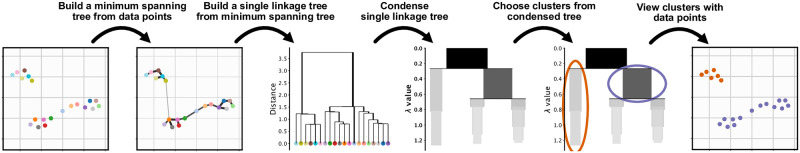
HDBSCAN density-based clustering.Clusters are found by generating a graphical representation of data, and then clustering on the graph. The data shown in this figure are from the latent projections from Fig 1. Notably, the three clusters in Fig 1. are clustered into only two clusters using HDBSCAN, exhibiting a potential shortcoming of the HDBSCAN algorithm. The grey colormap in the condensed trees represent the number of points in the branch of the tree. Λ is a value used to compute the persistence of clusters in the condensed trees.